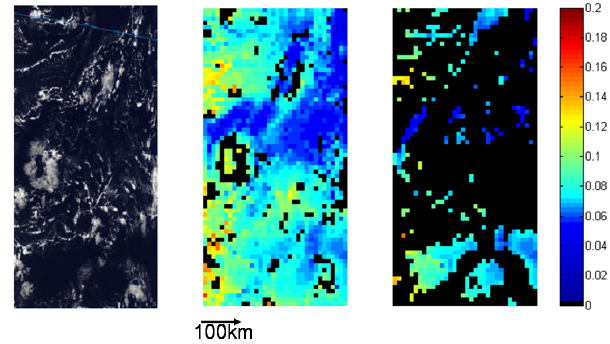
Fig. 2. Example of the consequences of removing MODIS aerosol retrievals collocated with more than 20% cloud fraction. Left – part of the 12 August 2007 MODIS visbile image over the Atlantic ITCZ. Center: the MODIS operational AOD retrieval for the scene. Right – the same retrieval after eliminating all AOD retrievals col- located with higher than 20% cloud fraction. Note how AOD re- trievals in the vicinity of any cloud are removed leaving only AOD in cloud-free